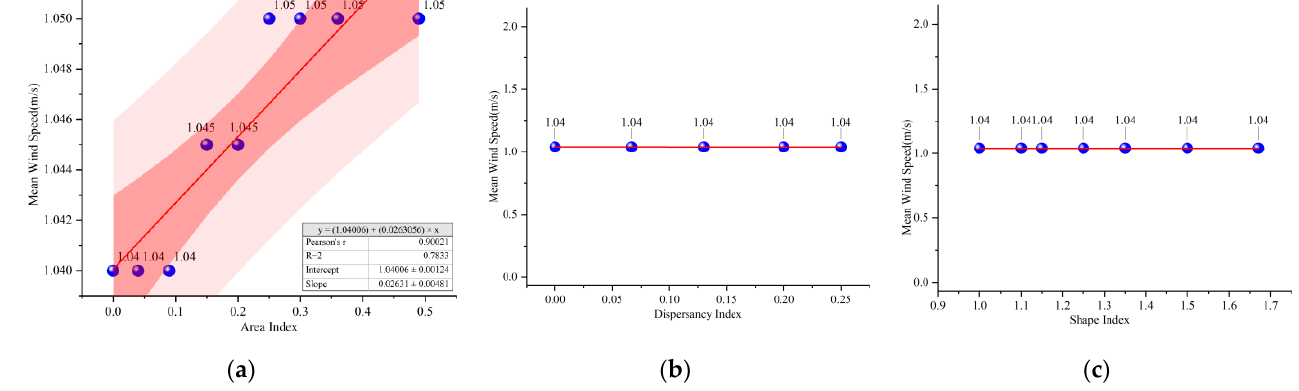
Figure 11. Correlation analysis of wind speed and microclimate for different water layout factors: ( a ) Water body area index; ( b ) Water body dispersion index; ( c ) Water body shape index.